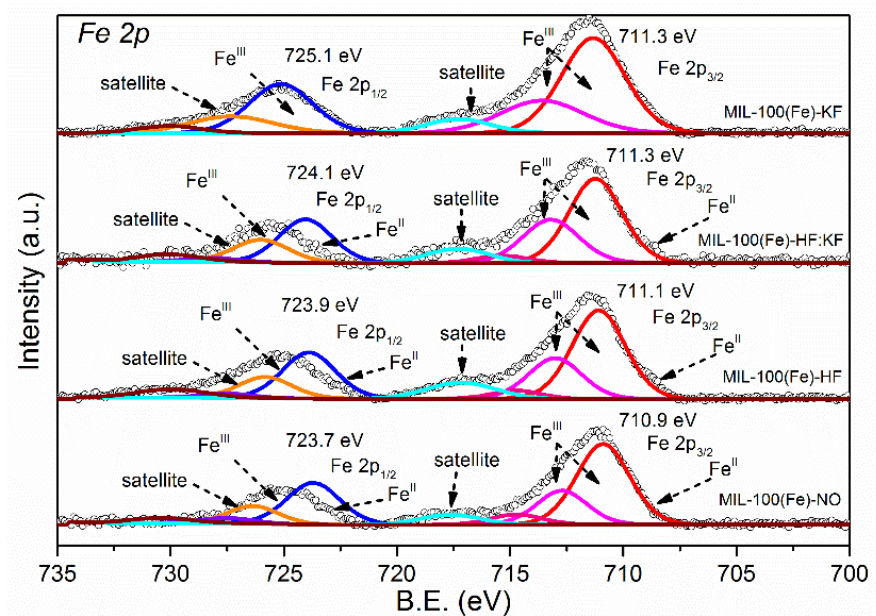
Figure 6. XPS spectra of the synthesized samples. The figure shows the Fe 2p core-level spectra. If we now look at the F 1s spectra (Figure 7) of the samples prepared in the presence of fluorine, it can be seen that only one peak appeared, centered at 683.8 eV for samples MIL-100(Fe)-HF:KF and MIL-100(Fe)-HF and at 684.2 eV for sample MIL-100(Fe)-KF. In all cases, this peak was located at a binding energy characteristic of metal fluorides. The difference in binding energy between MIL-100(Fe)-KF and the other two samples was due to the fact that HF was not used in the synthesis, resulting in a more defective